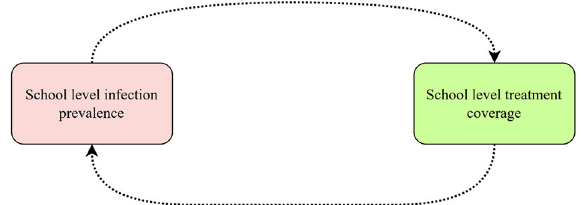
equation model (SEM) of the following structure ( Figure A1